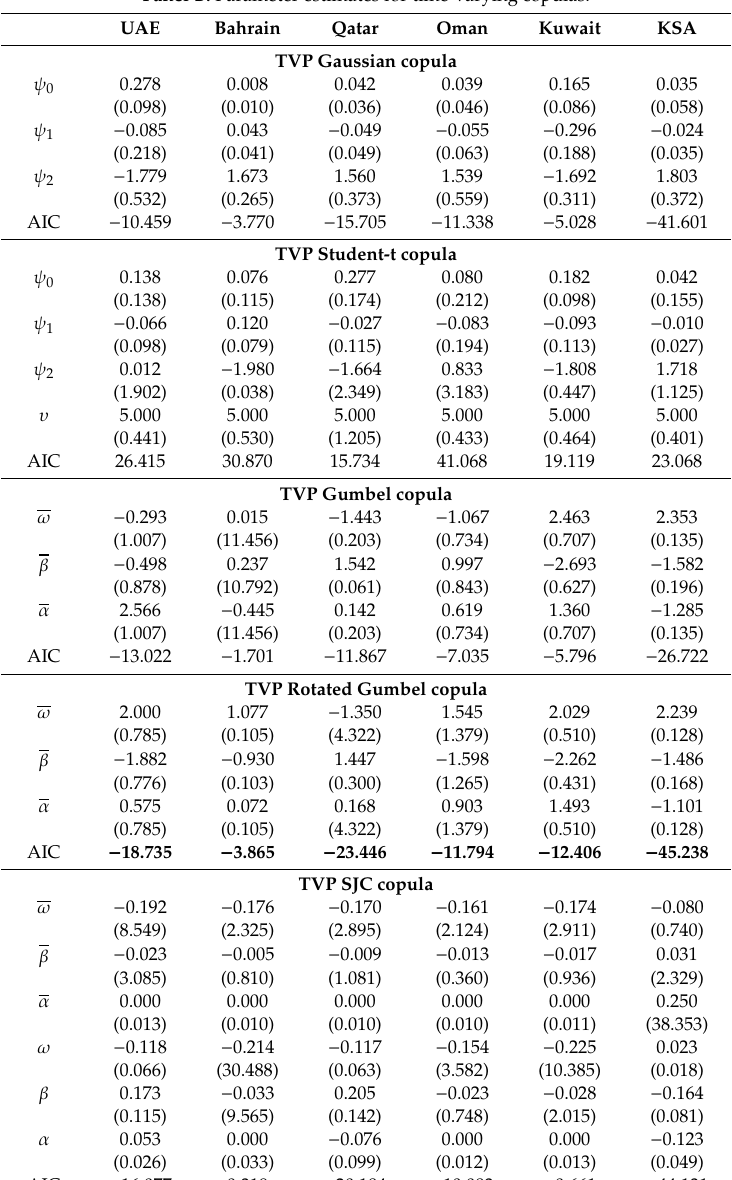
Panel B: Parameter estimates for time-varying